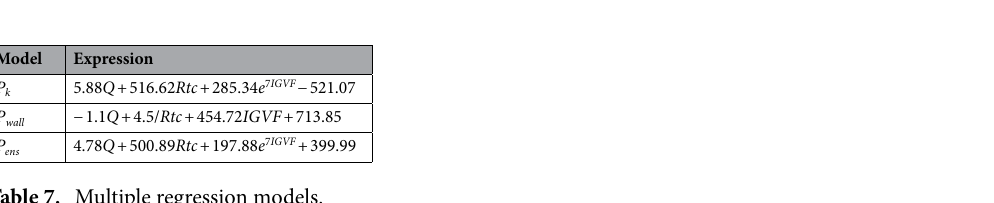
Table 7. Multiple regression models.